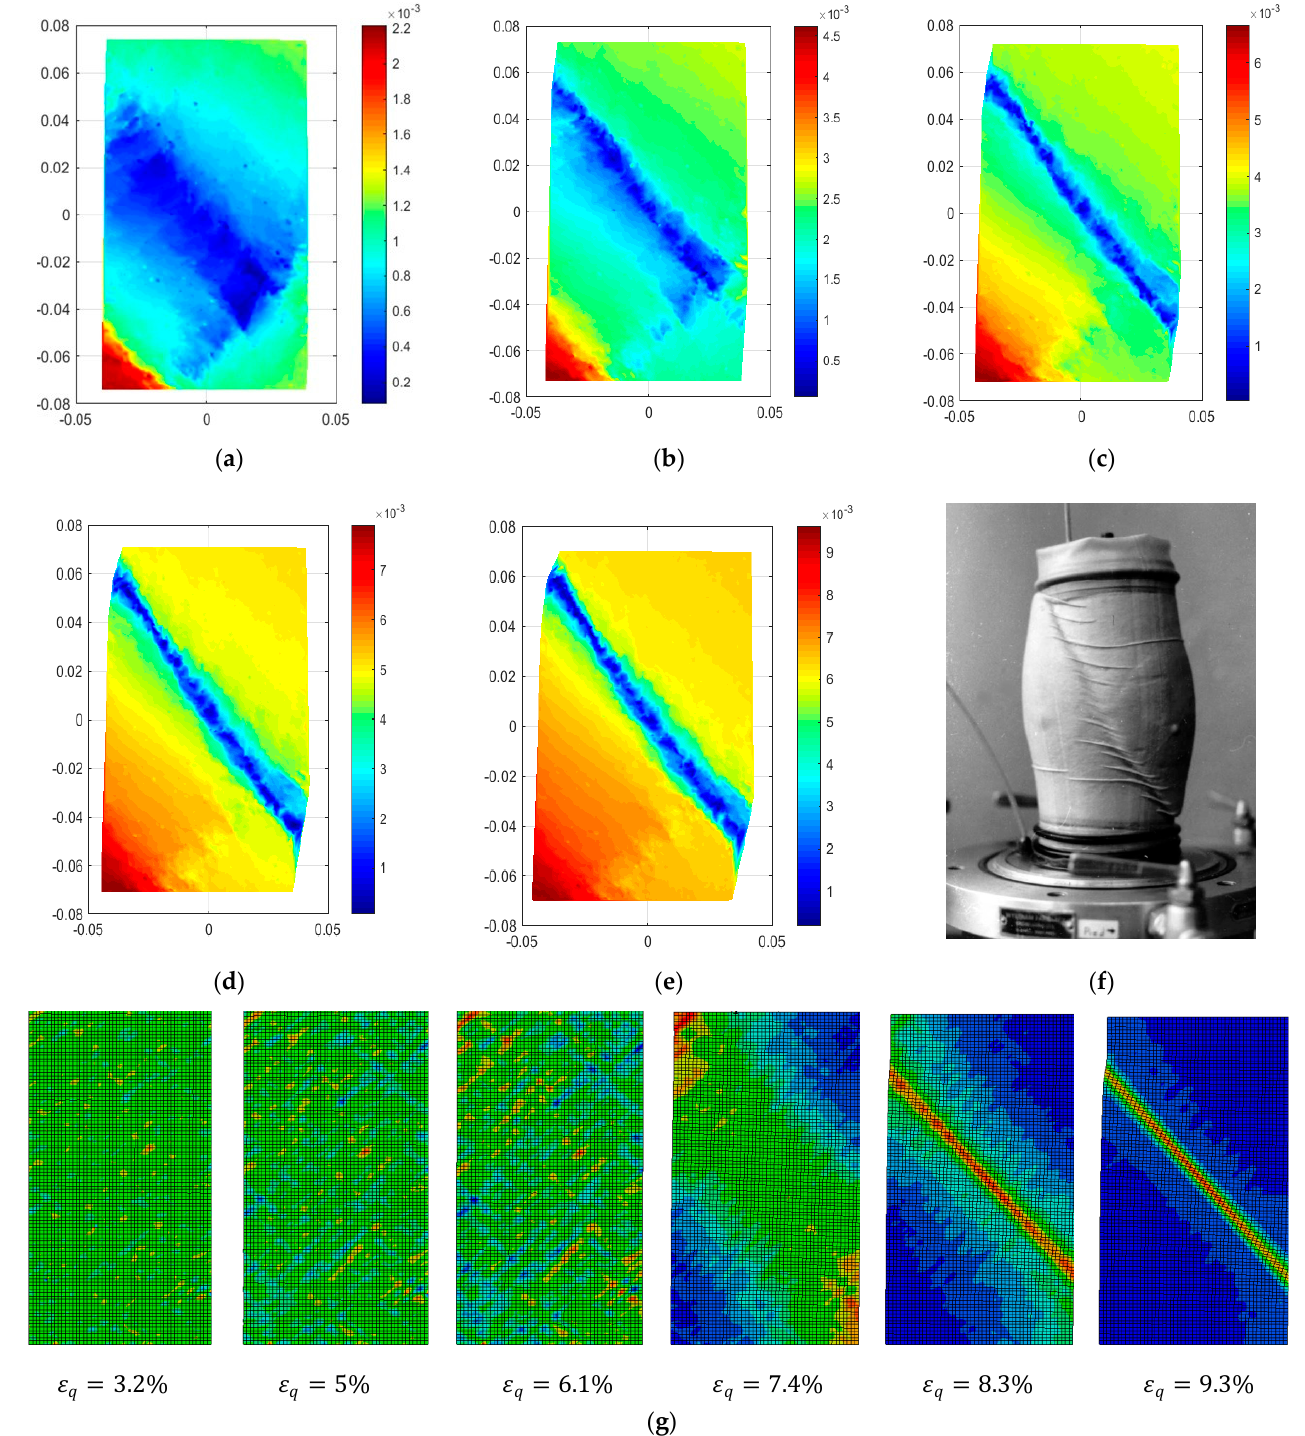
Figure 11. Total particles displacements. ( a ) 𝜀 (cid:2869)(cid:2869) = 0.5%. ( b ) 𝜀 (cid:2869)(cid:2869) = 0.7%. ( c ) 𝜀 (cid:2869)(cid:2869) = 0.9%. ( d ) 𝜀 (cid:2869)(cid:2869) = 1.5%. ( e ) 𝜀 (cid:2869)(cid:2869) = 10%. ( f ) After Desrues and Chambon [30] . ( g ) Medicus and Schneider-Muntau [31].